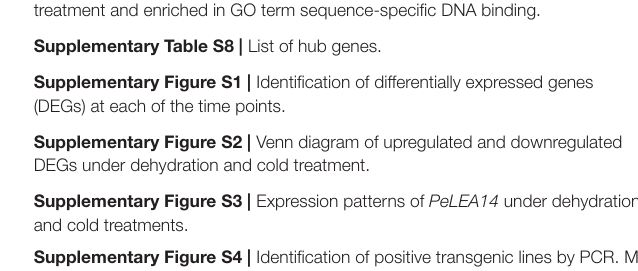
Supplementary Table S8 | List of hub genes.